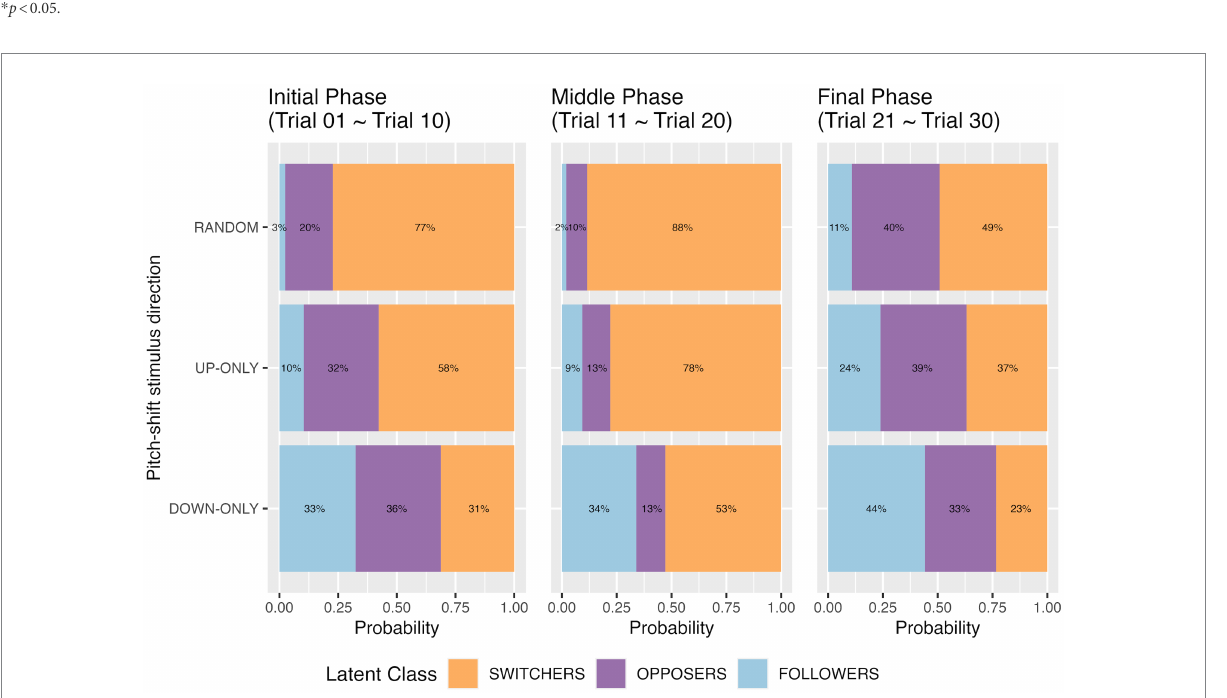
FIGURE 3 Predicted prior probability of latent class membership for the three pitch-shift stimulus directions at the initial phase (the first 10 trials), the middle phase (the middle 10 trials), and the final phase (the last 10 trials). Results are from the three-class latent class regression